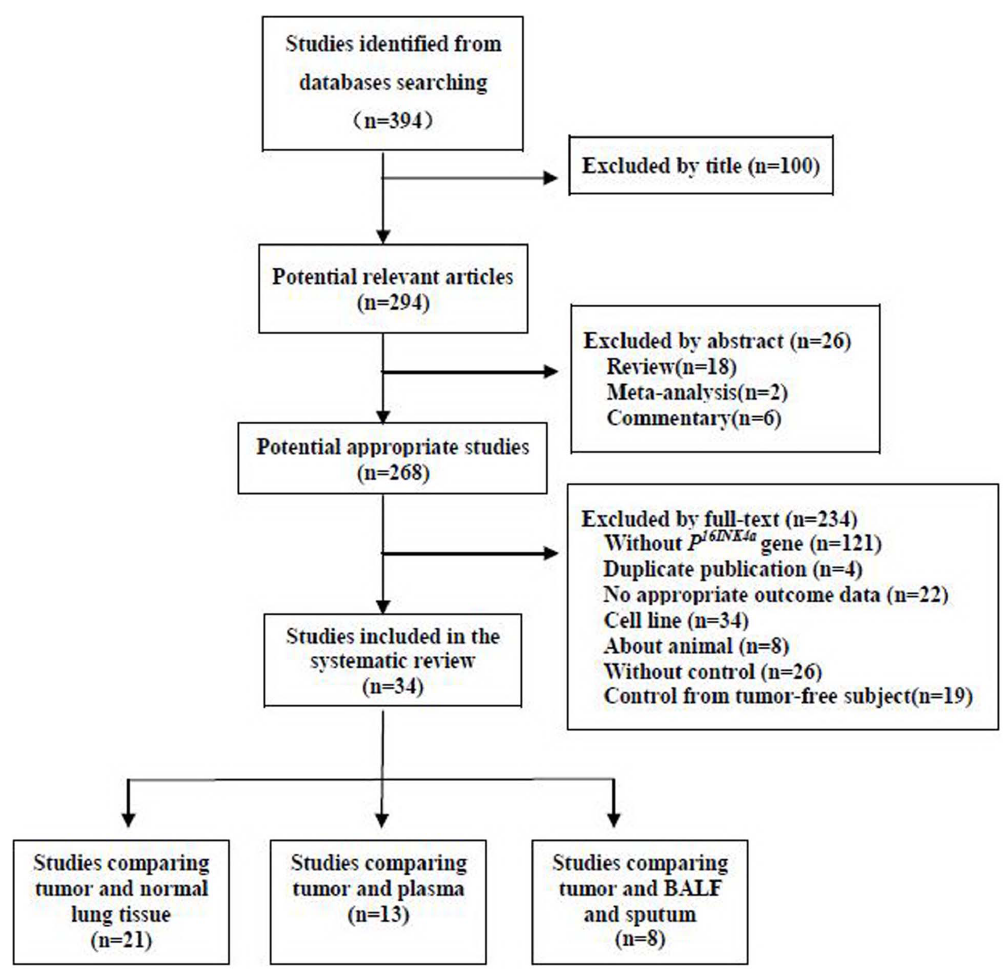
Figure 1. PRISMA flowchart of the literature search strategy for systematic review. (Data from some studies was used more than once, as they reported data in multiple controls.).